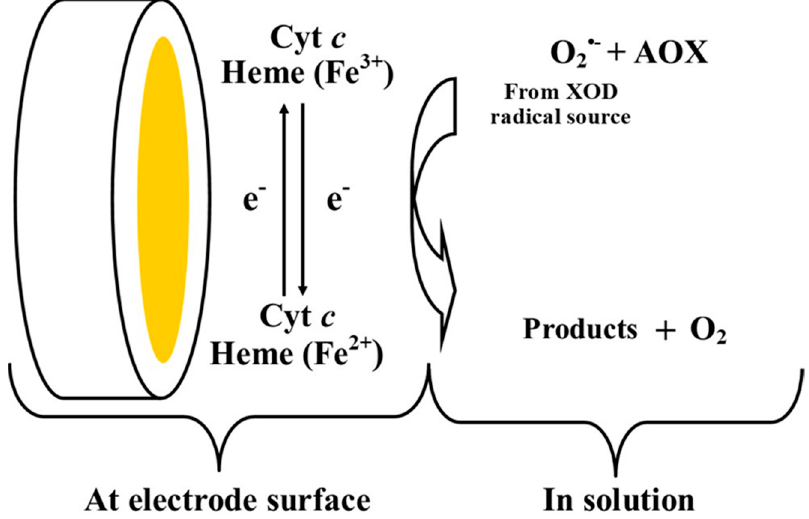
Figure 6. Cyt c sensor in determining superoxide scavenging activity of antioxidant (Cyt c : Cytchrome c ; AOX: Antioxidant; HX: Hypoxanthine; XOD: Xanthine